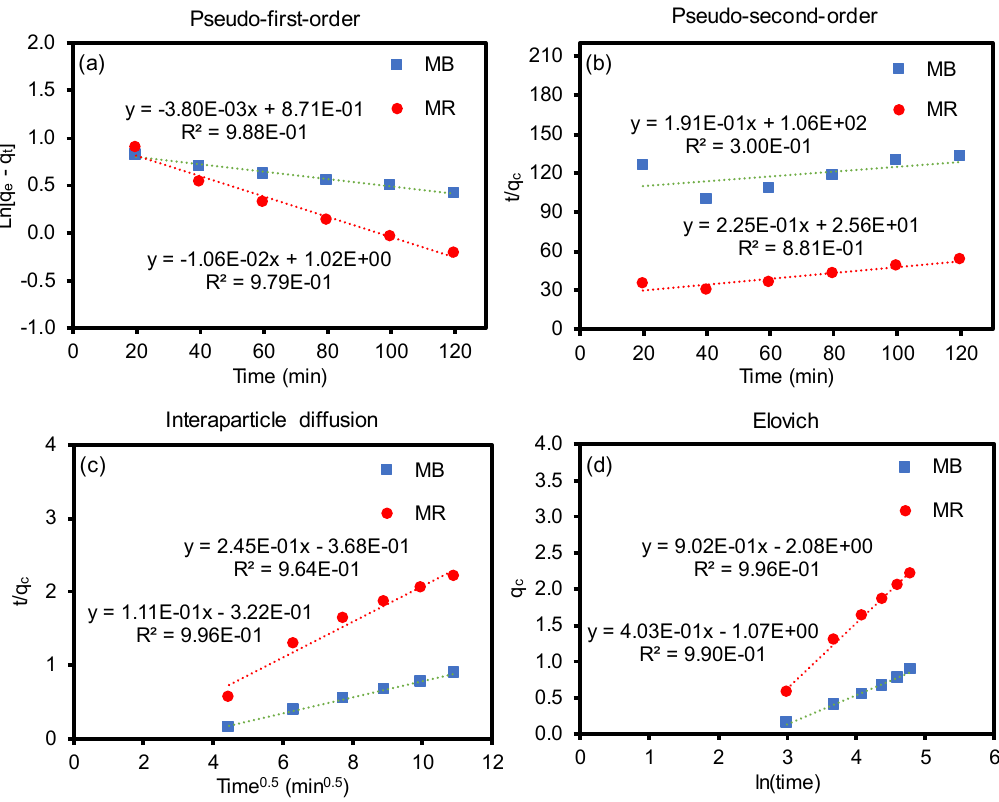
Figure 7. Adsorption kinetic models of MB and MR on the cGO–PAN composite nanofiber membranes ( a ) pseudo-first-order, ( b ) pseudo-second-order, ( c ) interparticle diffusion, and ( d ) Elovich. Table 2. Adsorption kinetic parameters of MB and MR on the cGO–PAN composite nanofiber membranes obtained from graphs in Figure 7.